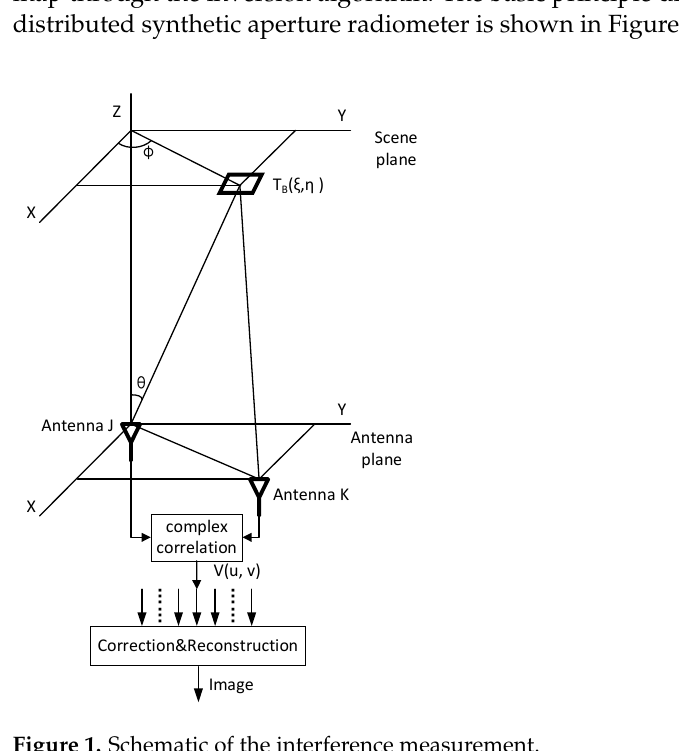
Figure 1. Schematic of the interference measurement.